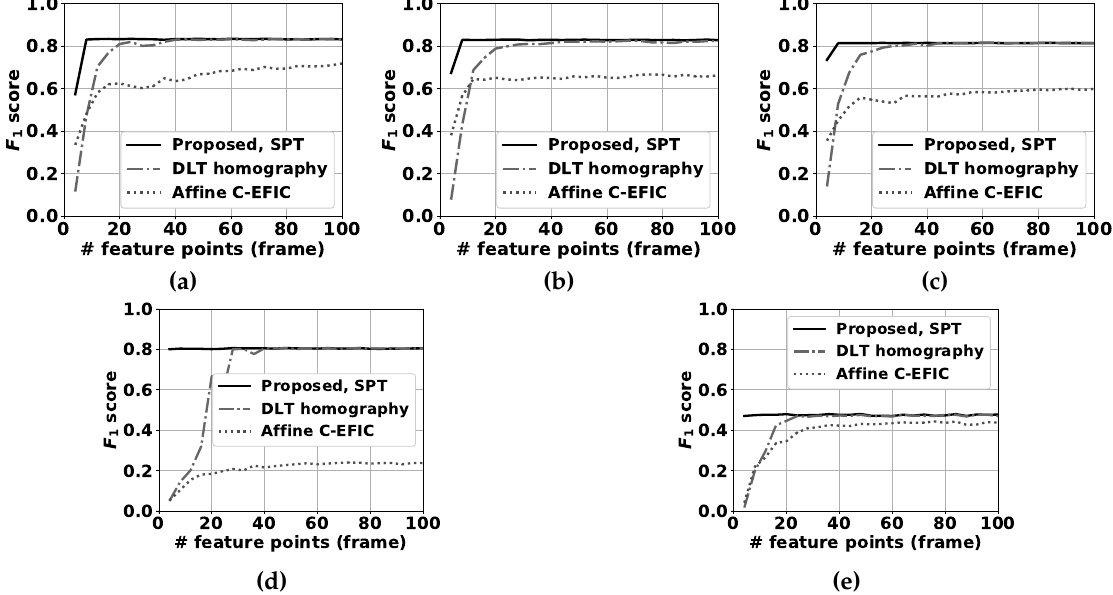
Figure 11. F 1 scores for the full FGBG segmentation method in the variable tilt sequences. The proposed method for simultaneous pan and tilt (SPT) is compared to the DLT homography method [24] and the affine compensation mechanism used before in C-EFIC [3] for 5 sequences; ( a ) classroom pan/tilt 1, ( b ) classroom pan/tilt 2, ( c ) classroom pan/tilt 3, ( d ) street outdoor day ( e ) parking outdoor night.